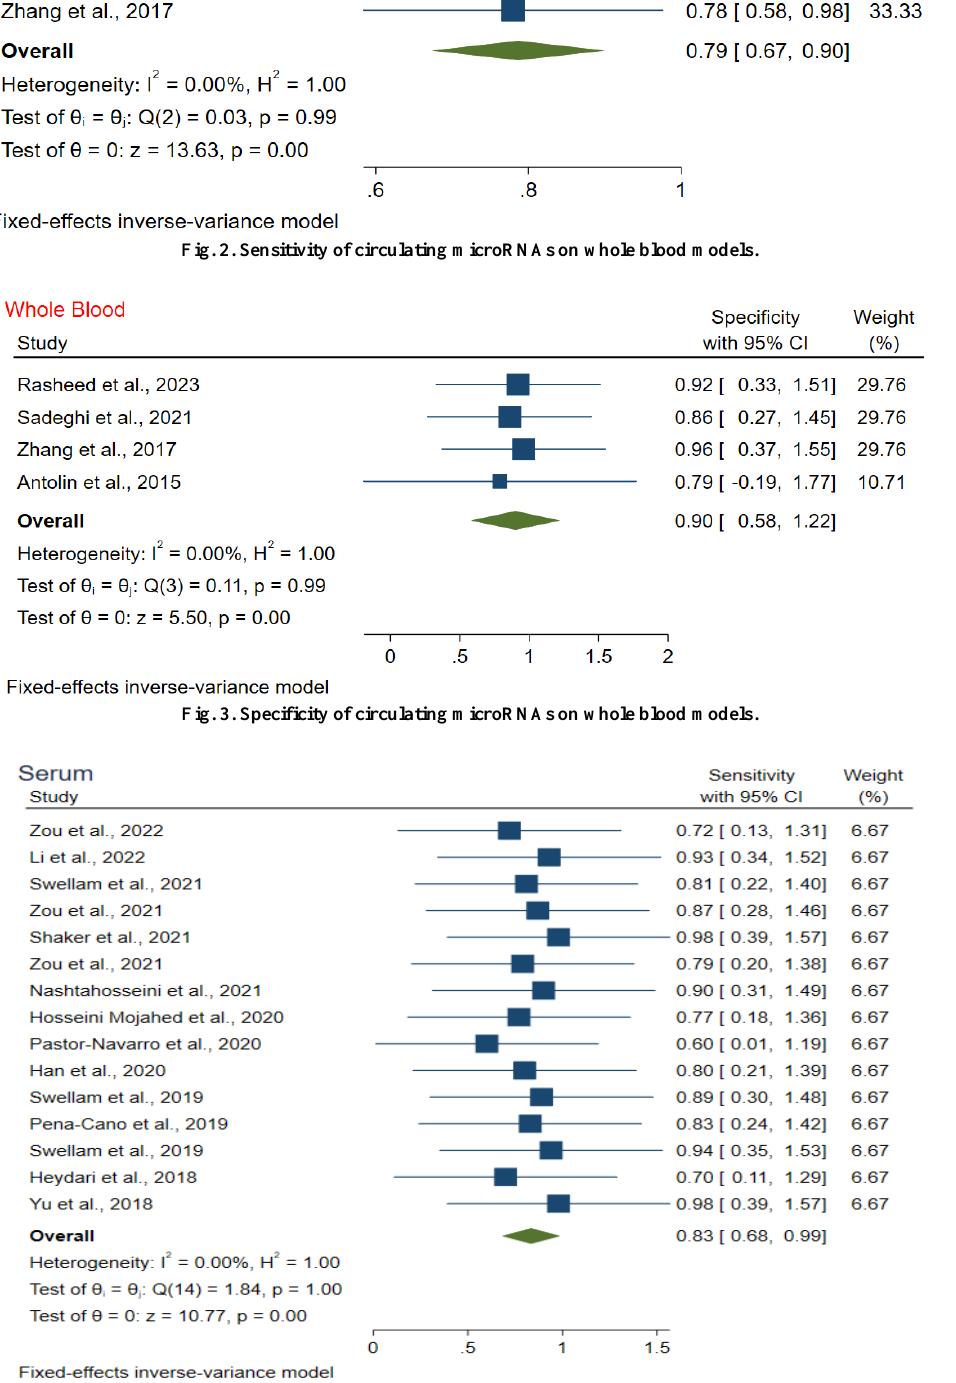
Fig. 4. Sensitivity of circulating microRNAs on serum